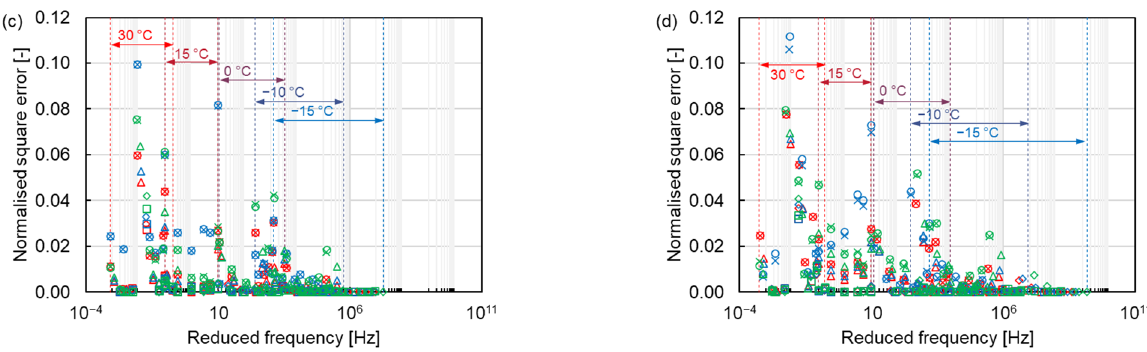
Figure 11. Normalised square errors of ( a ) AC 11-NB, ( b ) AC 11-PMB, ( c ) SMA 11-NB and ( d ) SMA 11-PMB.